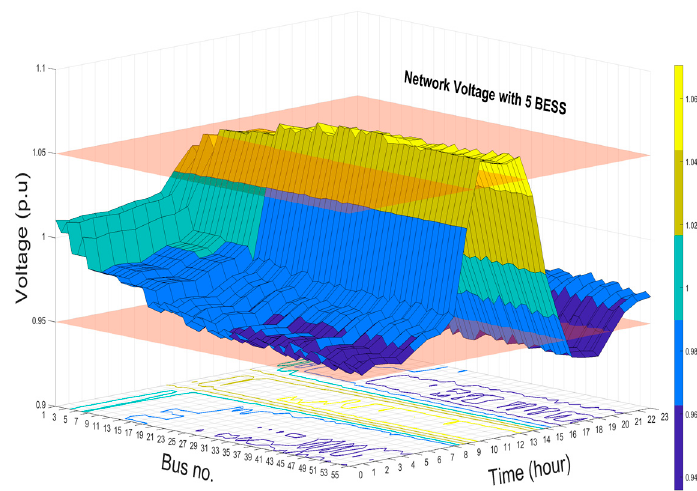
Figure 11. Network voltage profile with 5 BESS installed.